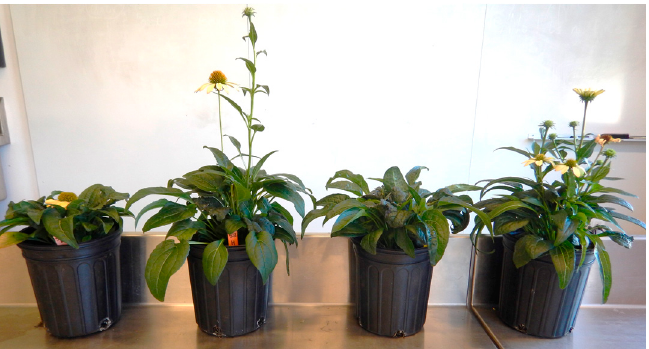
Figure 2. Representative plants of ‘Mellow Yellow’ coneflower at the conclusion of the 69-day experiment. Plants were maintained at either 40% VWC or 18% VWC and received either 100% (12 g/plant) or 50% (6 g/plant) of the medium bag rate of controlled release fertilizer. Treatments were 18% VWC 50% (6 g/plant) CRF, 40% VWC 50% CRF, 18% VWC 100% CRF, and 40% VWC 100% CRF (left to right).